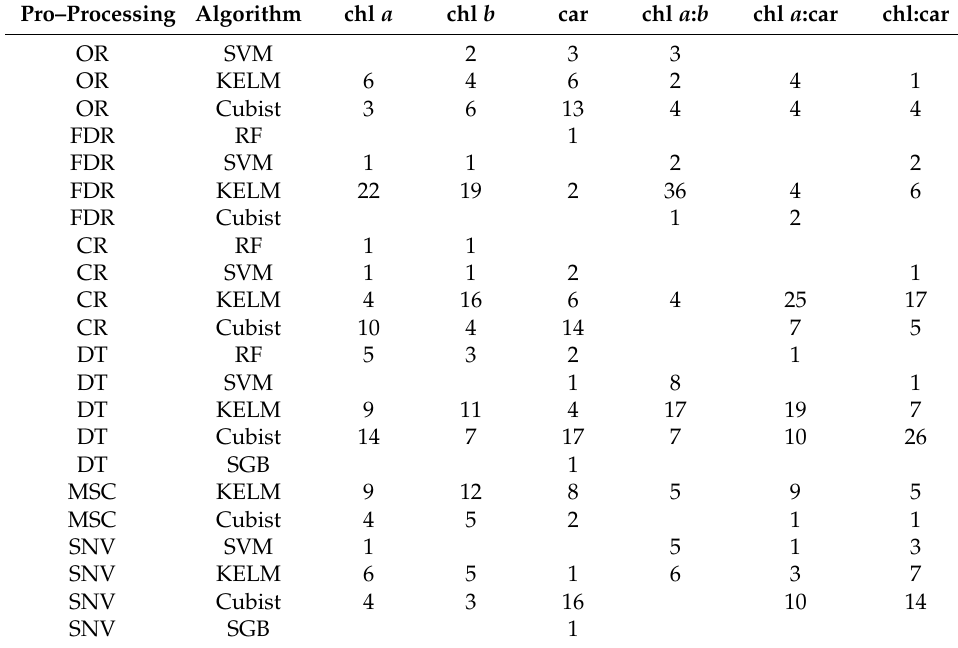
Table 4. Optimal combinations of the pre-processing techniques and machine learning algorithms after 100 repetitions.